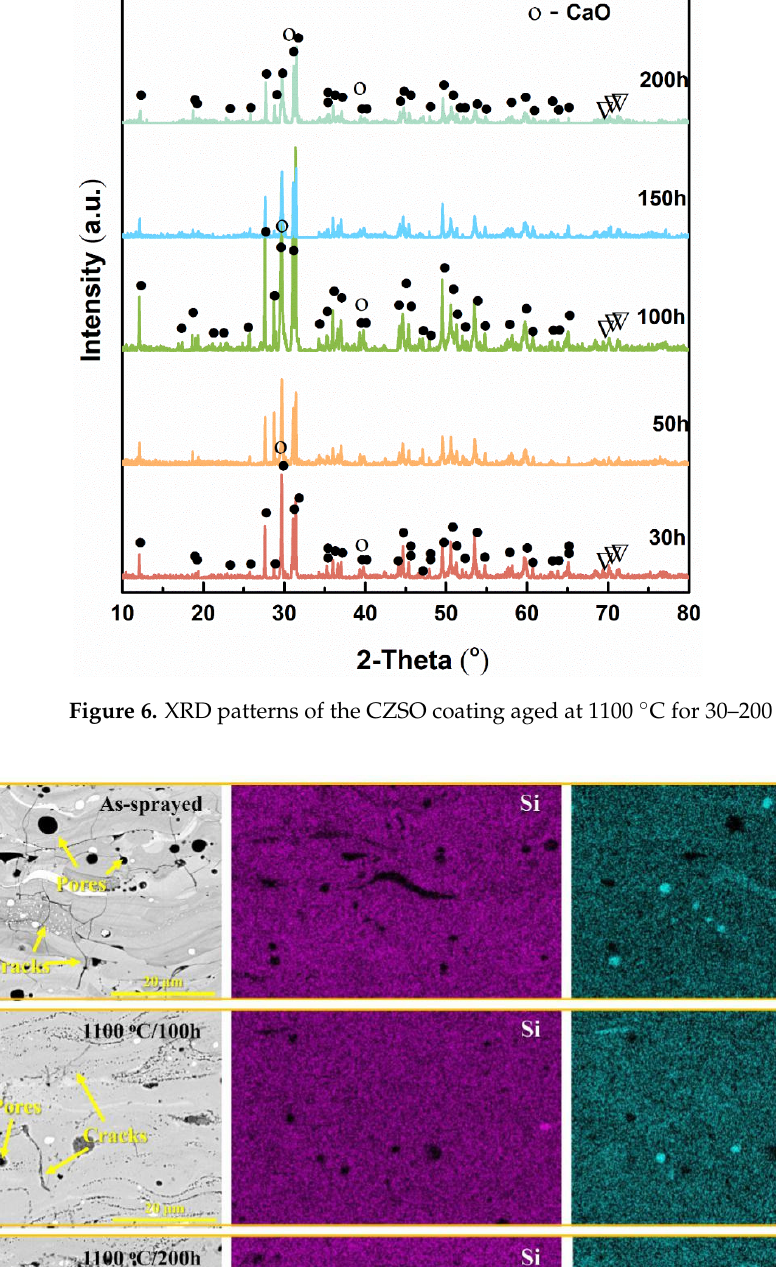
Figure 8. Indentation morphologies under different loads of as-sprayed ( a , b ), 30 h ( c ), 100 h ( d ), 150h ( e ) and 200 h ( f ) CZSO coating aged at 1100 °C.